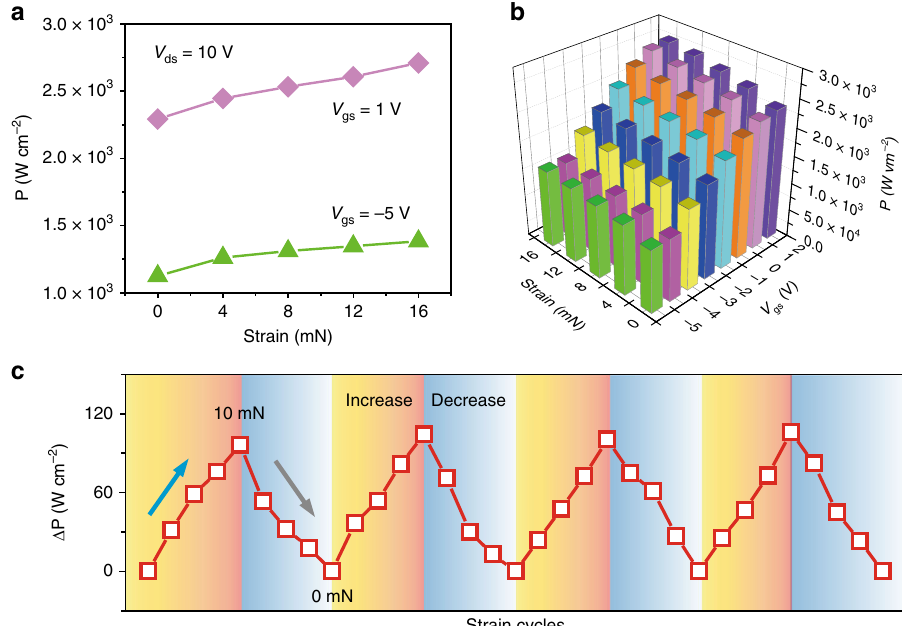
Fig. 4 Strain-controlled output power. a Output power density plots of under external strain from 0 to 16 mN at the gate voltage of − 5 V and 1 V. b 3D plots illustrating the relationship between the output power density and the input strain or gate voltage. c Reproducible procedures of loading or unloading strain (0 – 10 mN) in response to the relative output power density in cyclic